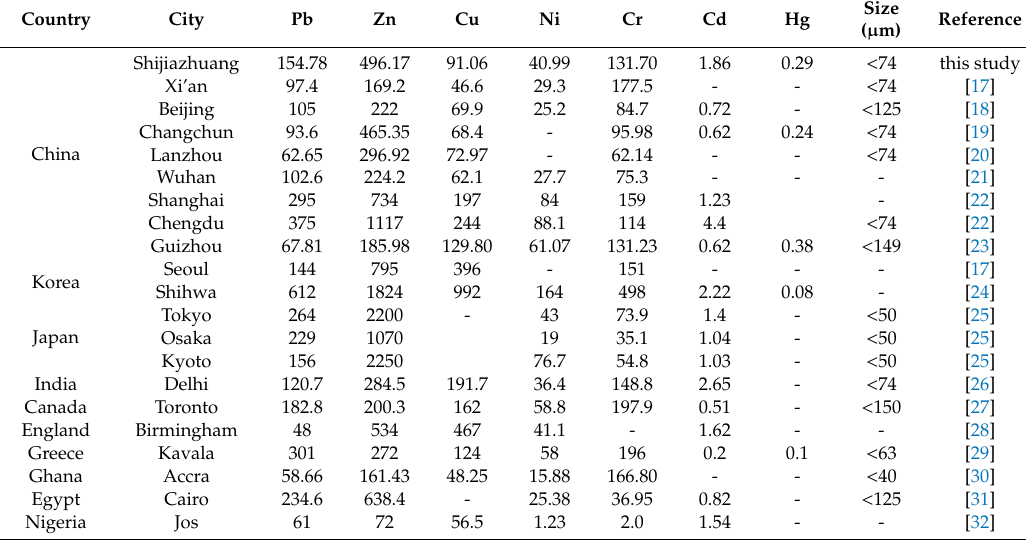
Table 1. Heavy metal distribution in street dusts of di ff erent cities (mg · kg − 1 ). Country City Pb Zn